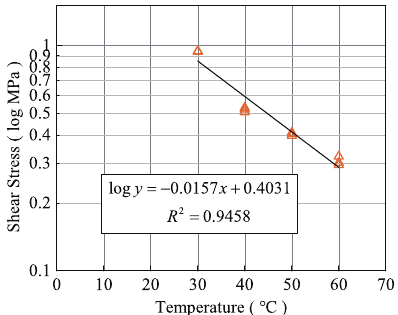
Figure 11. Test temperatures dependency of shear stress.